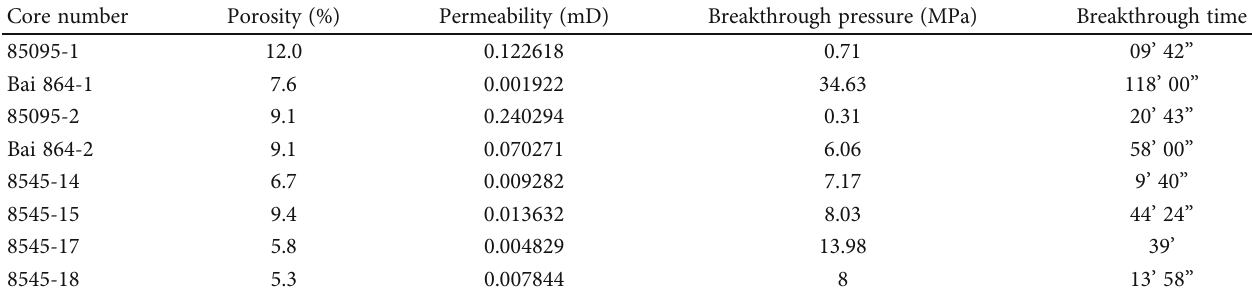
Table 6: Experimental results of gas injection sealability evaluation at the top of 1-inch diameter plunger cores.